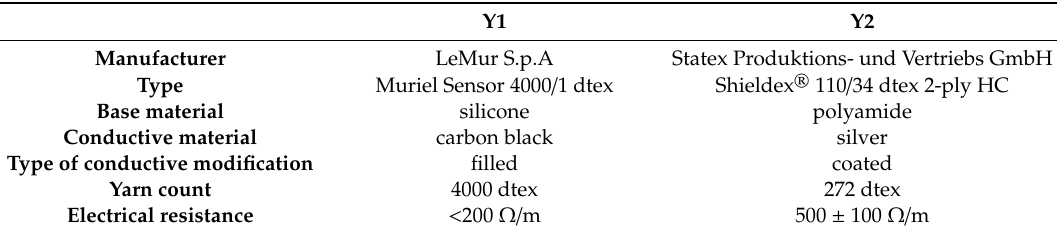
Table 1. Properties of the examined sensor yarns